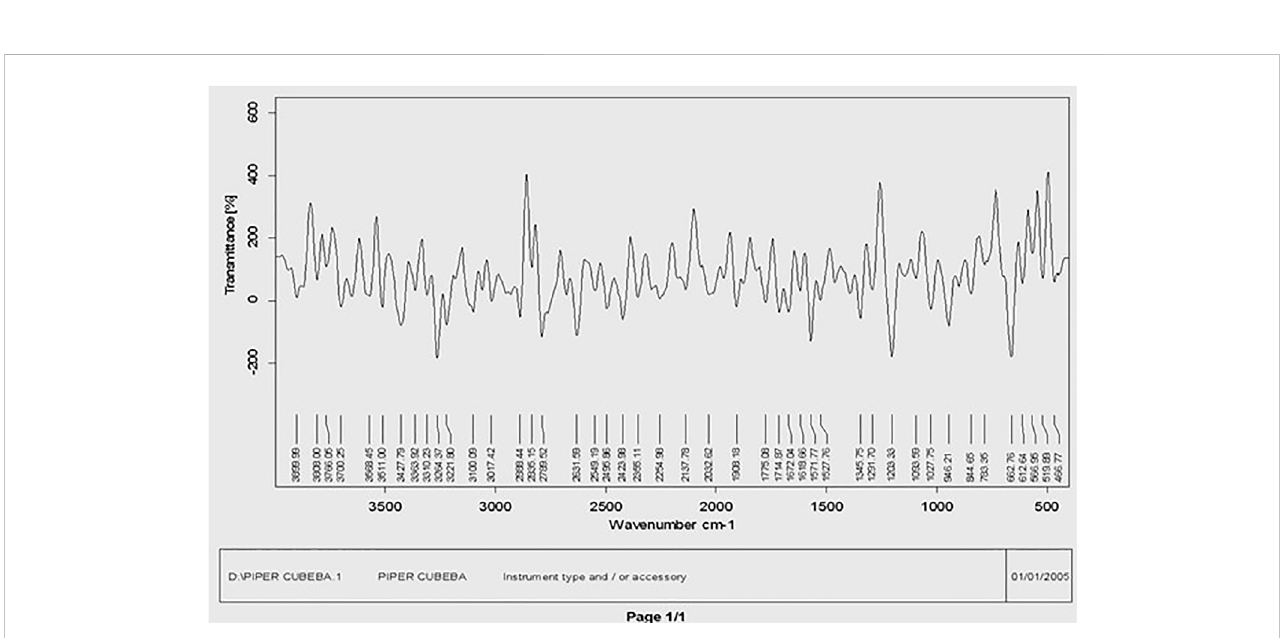
FIGURE 3 FTIR spectra of silver nanoparticles synthesized from the Piper cubeba